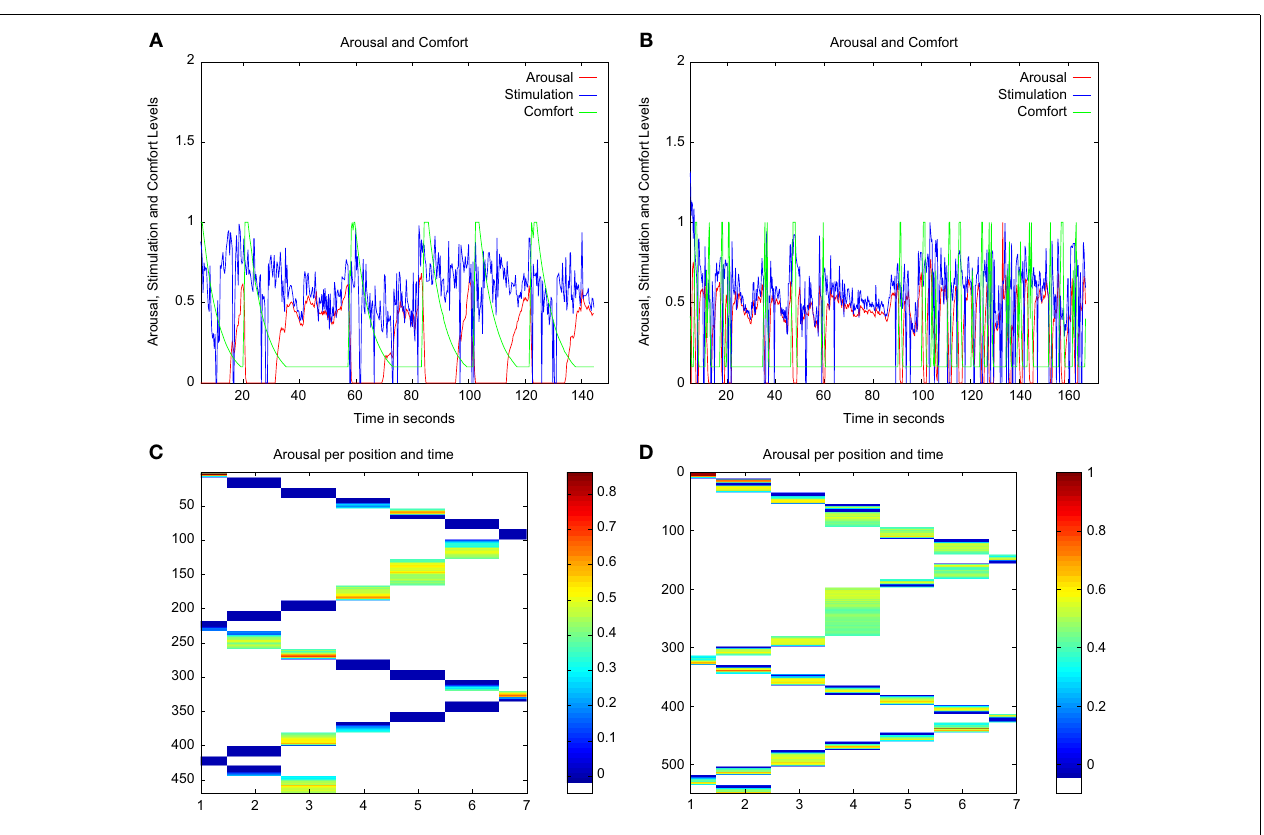
FIGURE 8 | Summary of the main variables of the architecture from experimental runs in the more crowded environment for both robot profiles. Panels (A,B) show the variations in arousal and the variables used to compute the arousal level. Panels (C,D) show, for each robot profile, the arousal of the robot at each time for each position of the setup the robot can reach. (A) Evolution of the Arousal (red), Comfort (green), and Stimulation